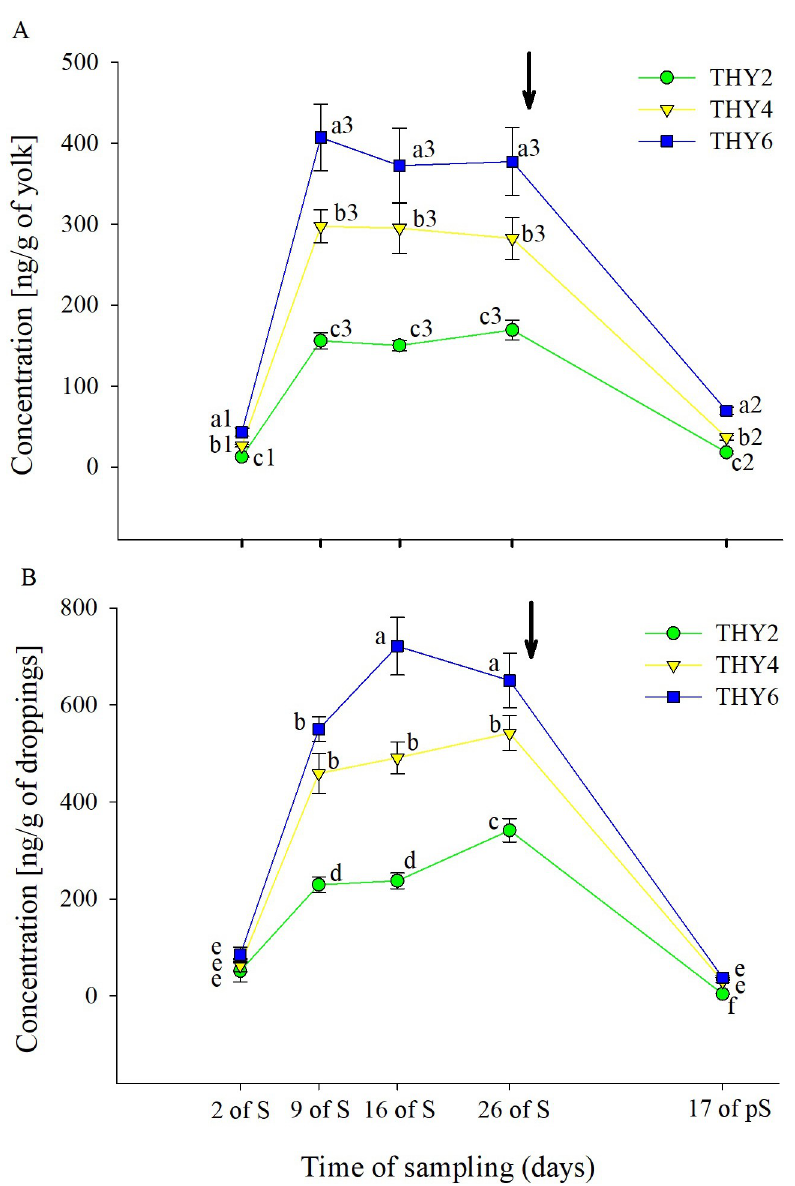
Fig 2. Thymol concentration in quail egg yolk and droppings. Mean ± SEM of thymol concentration (ng/g) in the (A) egg yolk and (B) droppings from females fed on diets with 2, 4, and 6.25 g of thymol/kg of feed (THY2, THY4 and THY6, respectively) at 2, 9, 16, and 26 days of the supplementation period (S) and after 17 days of supplement withdrawal (pS). Arrow pointing down indicates the end of the S period. In Fig 2A different letters (a, b, c) and numbers (1, 2, 3) indicate statistical differences for the diet supplied and time of sampling, respectively. In Fig 2B different letters (a, b, c, d, e, f) indicate statistical differences for the interaction. The same 15 females (5 per THY supplemented diet) were sampled on each of the five sample points (75 eggs and 45 droppings samples total). BASAL and VEHICLE samples were evaluated at the beginning and end of the day at each sample point to assure the absence of